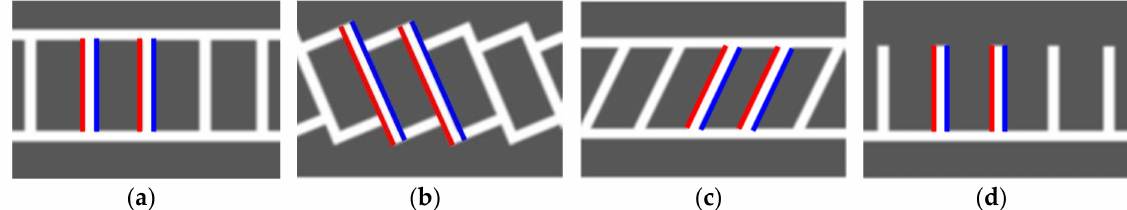
Figure 3. Four types of parking slot markings. ( a ) Rectangular type; ( b ) Slanted rectangular type; ( c ) Diamond type; ( d ) Open rectangular type.